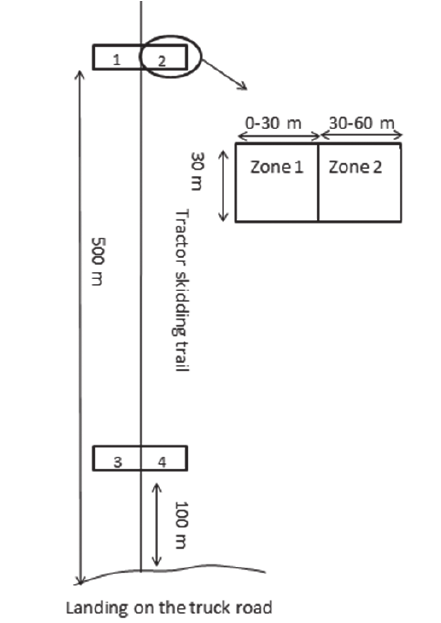
FIgURe 1. Schematic layout of sample